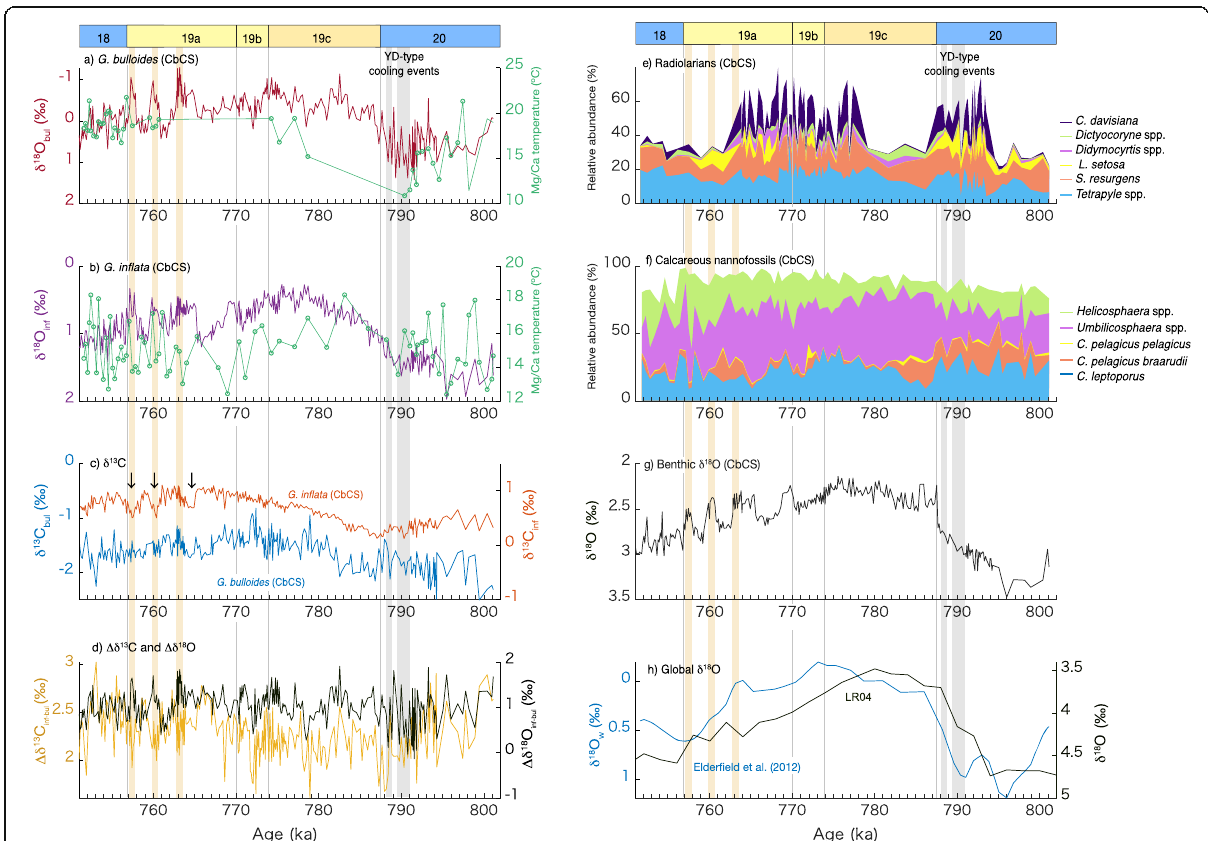
Fig. 2 Marine records of the Chiba composite section (CbCS) showing a δ 18 O (red) and Mg/Ca-based winter temperature (green) for G . bulloides , b δ 18 O (purple) and Mg/Ca-based winter temperature (green) for G . inflata (Suganuma et al. 2018; Haneda et al. 2020a), c δ 13 C for G . bulloides (blue) and for G . inflata (orange), d Δδ 13 C inf-bul (yellow) and Δδ 18 O inf-bul (black), e , f microfossil relative abundances for e radiolarians (Suganuma et al. 2018 and this study), f calcareous nannofossils (Kameo et al. 2020), g benthic δ 18 O in the CbCS (Suganuma et al. 2018), h comparison to global mean δ 18 O of water ( δ 18 O w ) of Elderfield et al. (2012) (blue) and the benthic δ 18 O stack of Lisiecki and Raymo (2005) (black). Younger Dryas-type cooling events during Termination IX and distinct millennial events in δ 18 O of G . bulloides during MIS 19a are highlighted in gray and yellow. Arrows in Fig. 3c represent negative peaks in δ 13 C of G . inflata mentioned in the text. Figure 2 illustrates the data from 801 to 751